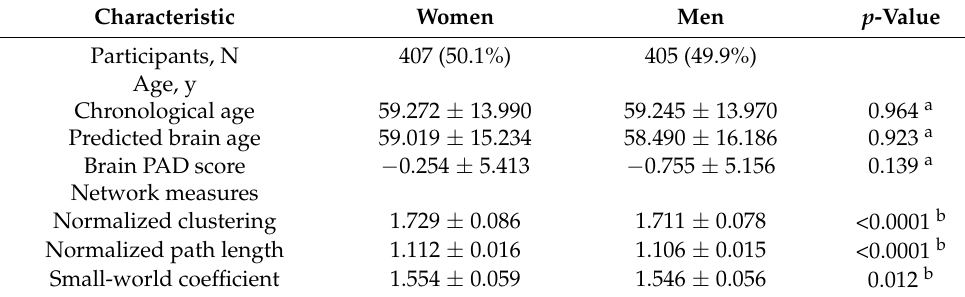
Table 1. Demographic characteristics of the participants.